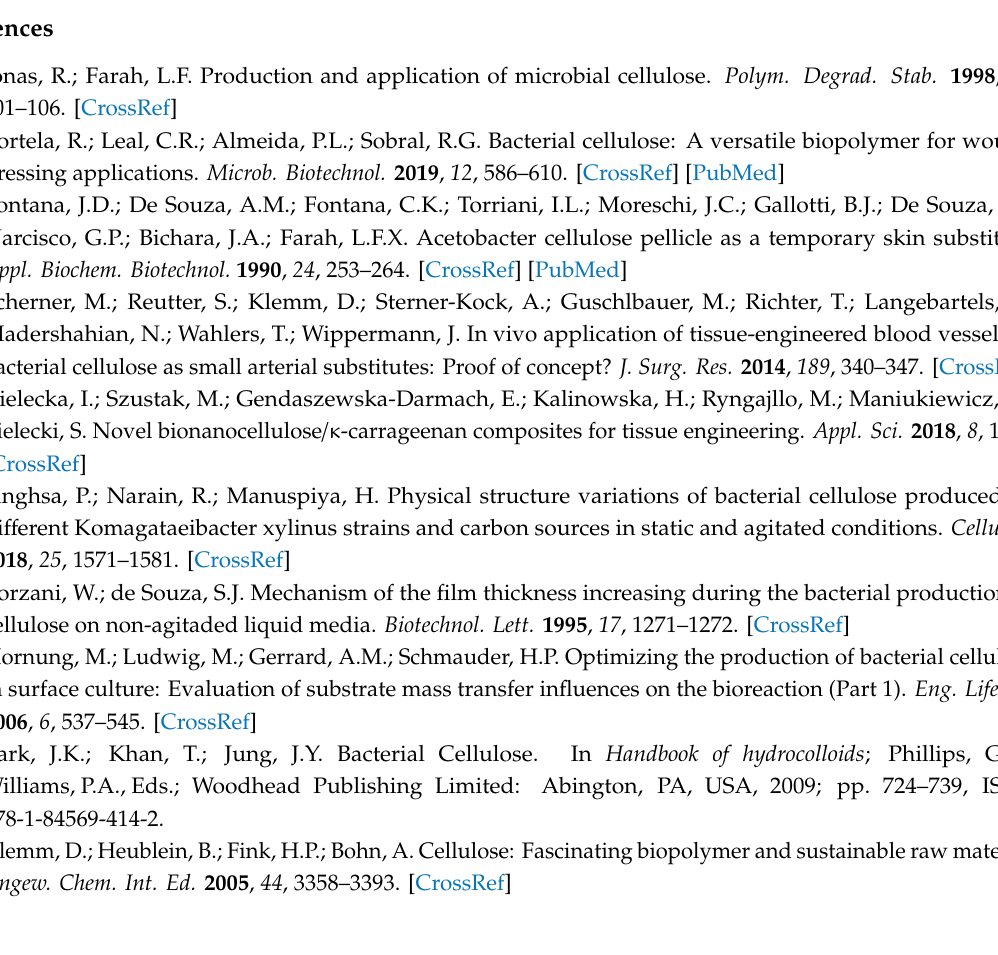
Figure A2. Main effect plots of the studied parameters for dry weight per surface unit. Figure A2. Main e ff ect plots of the studied parameters for dry weight per surface